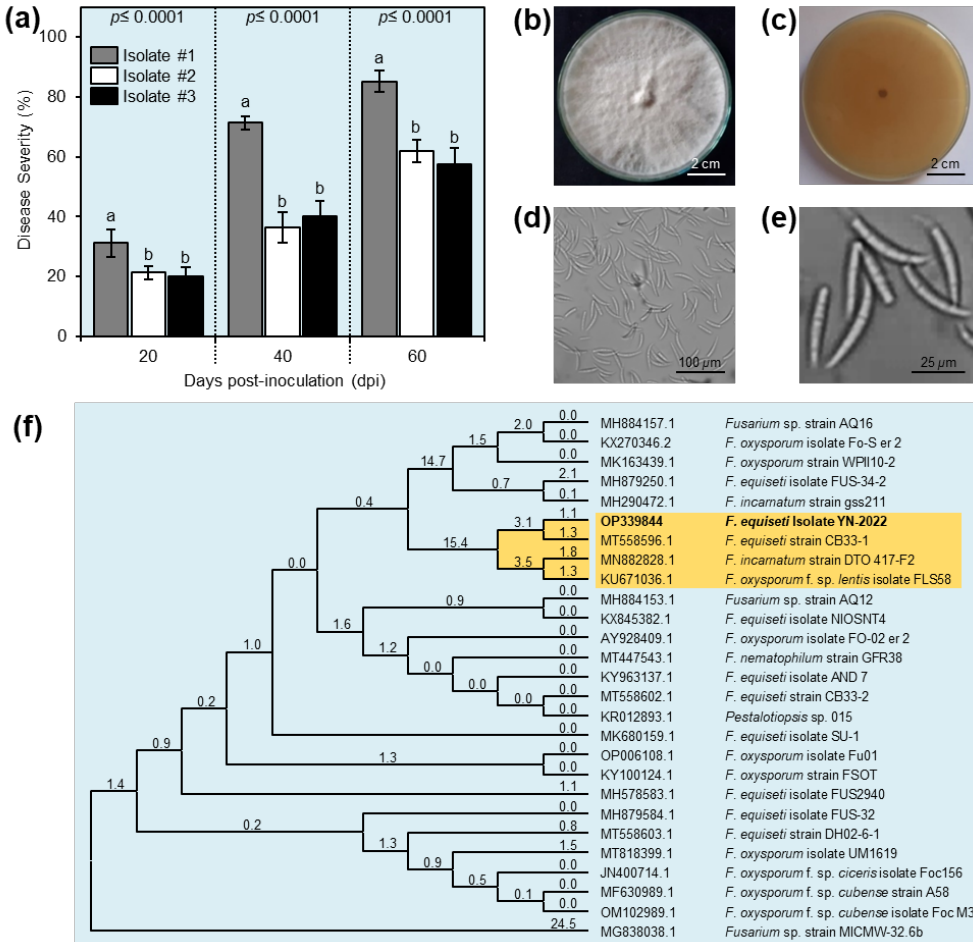
Figure 2. Pathogenicity, morphological characterization, and molecular identification of Fusarium equiseti isolates. ( a ) Disease severity (%) of different F. equiseti isolates on pepper seedlings (culti- var Top star) under greenhouse conditions. Values represent the means ± standard deviations (means ± SD). Different letters indicate statistically significant differences between treatments using the Tukey–Kramer honestly significant difference test (Tukey HSD; p <0.05). ( b , c ) Appearance of the fungal colony on potato dextrose agar (PDA) media from the top and the bottom of the petri dish, respectively, after 7 days of incubation at 27 ± 2 °C. ( d , e ) Microscopic typical appearance of hyaline, cylindrical, and multiple-cell macroconidia of F. equiseti . ( f ) Maximum-likelihood phylo- genetic tree using ITS-5.8S rDNA sequence of F. equiseti isolate YN-2022 (GenBank accession No. OP339844) (highlighted in bold along with its sequence from 25 reference strains/isolates retrieved from the recent available data in the National Center for Biotechnology Information (NCBI) Gen- Bank (https://www.ncbi.nlm.nih.gov/; accessed on 2 September 2022).